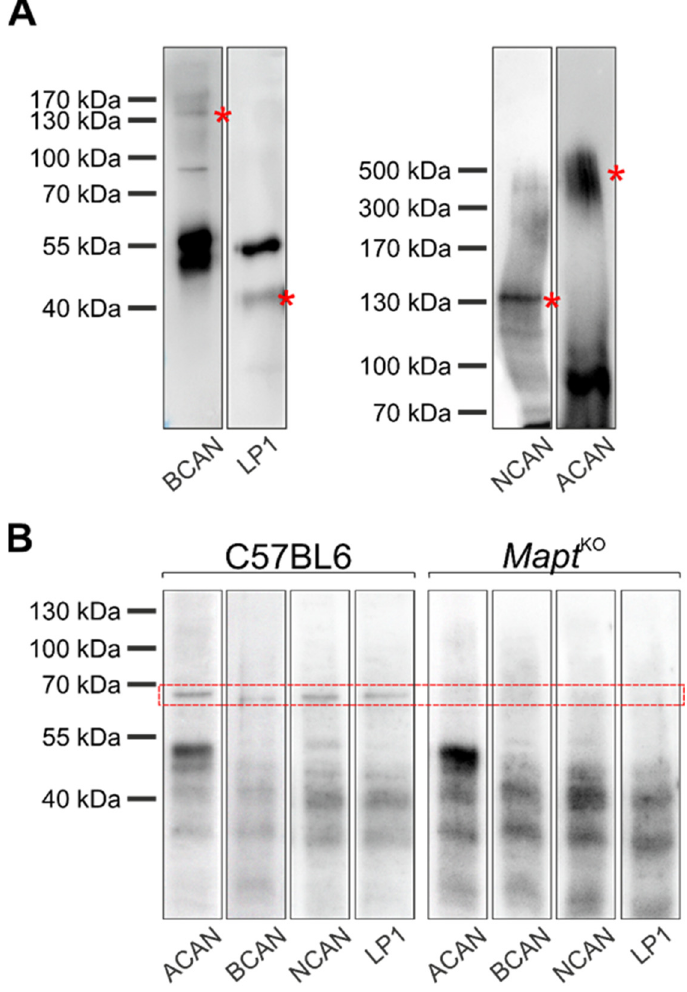
Figure 7. Interaction of perineuronal net components and tau protein. The interaction of several perineuronal net (PN) components and tau protein was investigated by combined co-immunoprecipitaion and Western blot analysis. ( A ) Verification of the target structure extraction (aggrecan (ACAN): AB1031 (Merck Millipore), at ~450 kDa; brevican (BCAN): clone 2 (BD Bioscience), at ~ 145 kDa; neurocan (NCAN): AF5800 (R&D Systems), at ~150 kDa; HAPLN1: AF2608 (R&D Systems), at ~40 kDa) by Dynabead-antibody-complex. Target structure specific bands were marked by an asterisk. The prominent signal about 55 kDa is attributed to the IgG heavy chain of the capture antibodies. ( B ) The formation of a PN-molecule-tau-complex was determined by total tau antibody (anti-pan tau (Dako)). A prominent tau-specific signal at ~65 kDa was detected when using C57BL6 brain homogenates for co-immunoprecipitation. When using brain homogenates of Mapt KO mice, no tau-specific signal was detected. The band pattern below 55 kDa in C57BL6 and Mapt KO mice is attributed to the IgG heavy and light chain of the applied capture antibodies. For illustration of exemplary blot lanes, brightness and contrast were